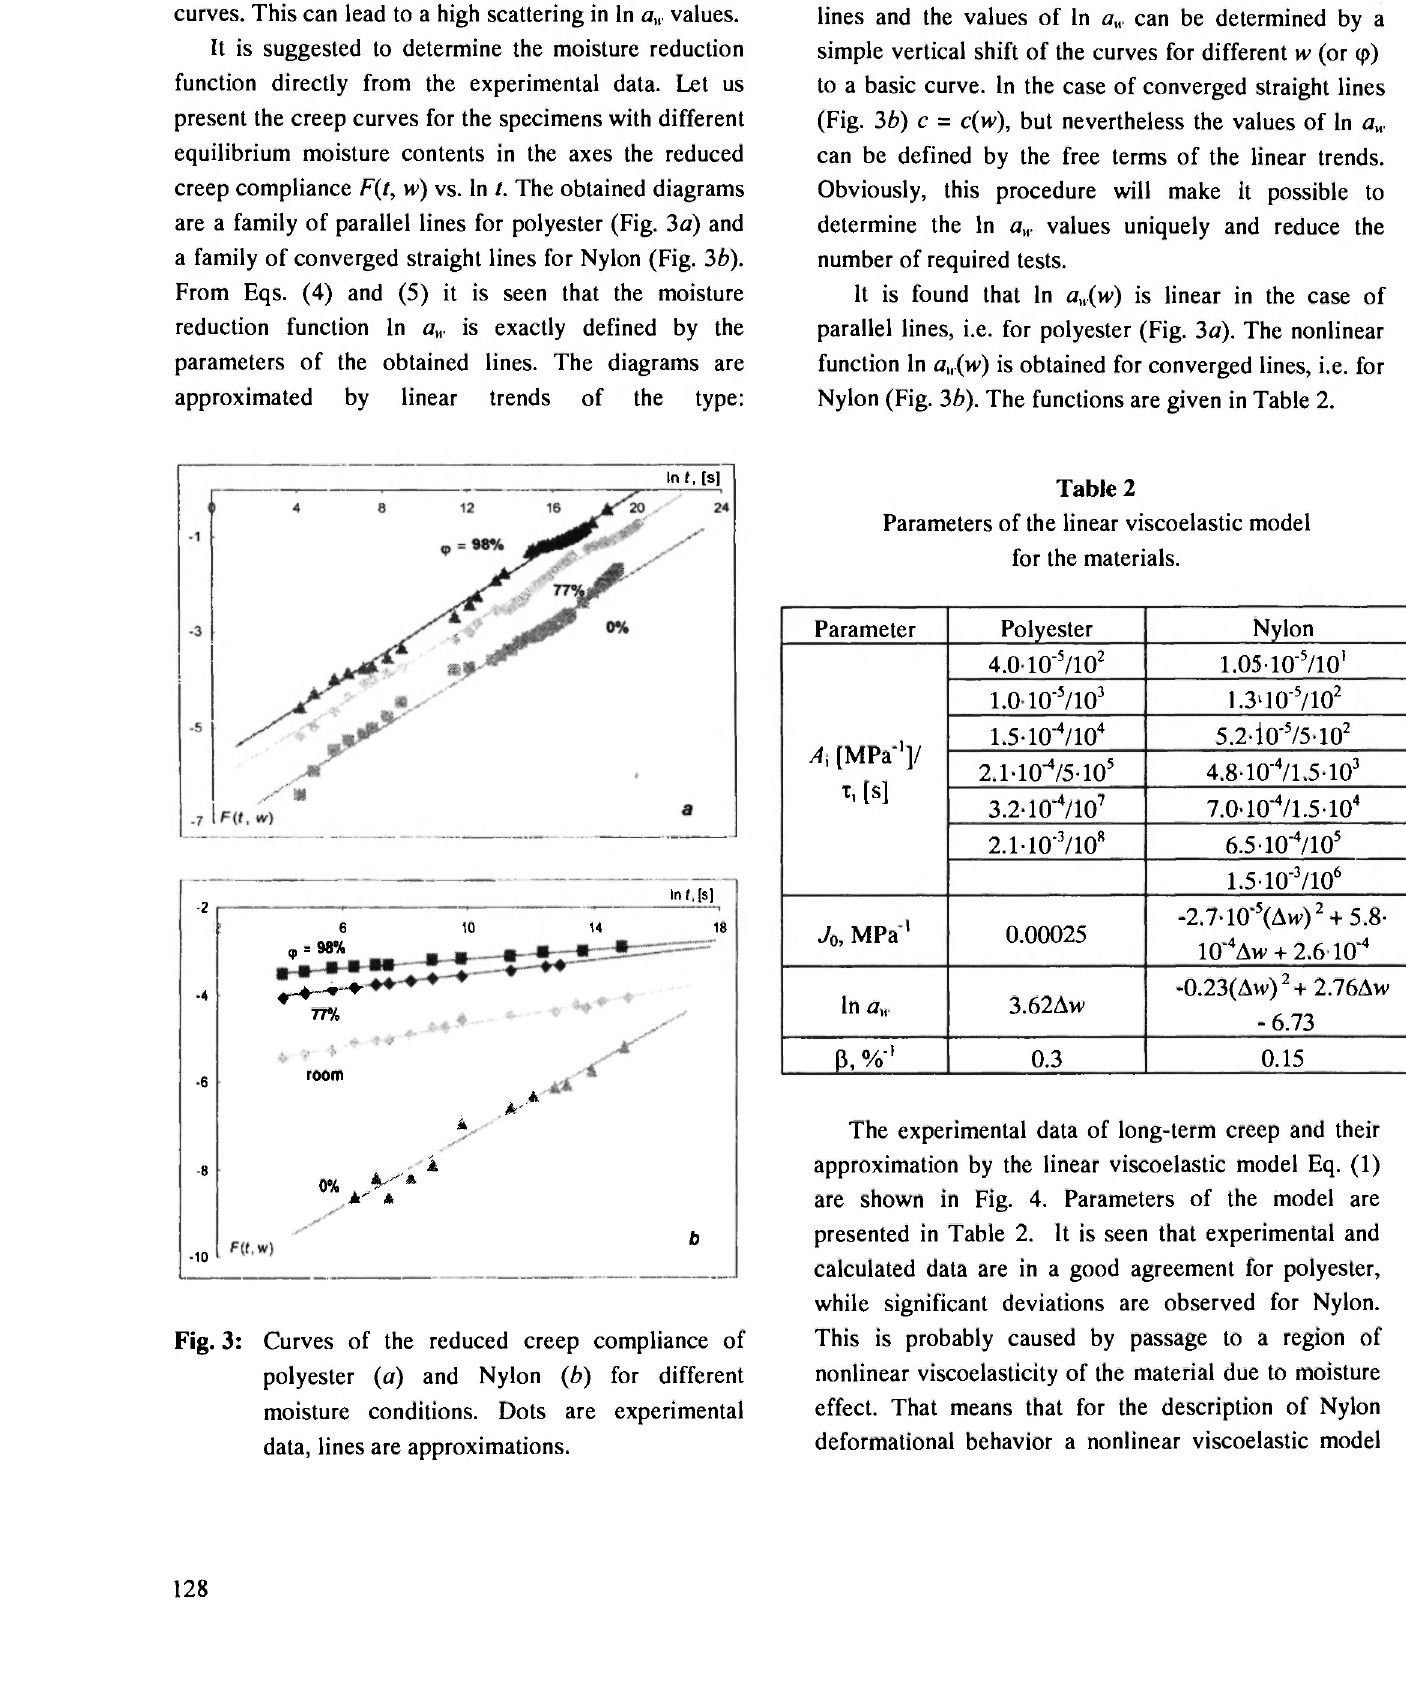
Fig. 3: Curves of the reduced creep compliance of polyester (a) and Nylon (b) for different moisture conditions. Dots are experimental data, lines are approximations.